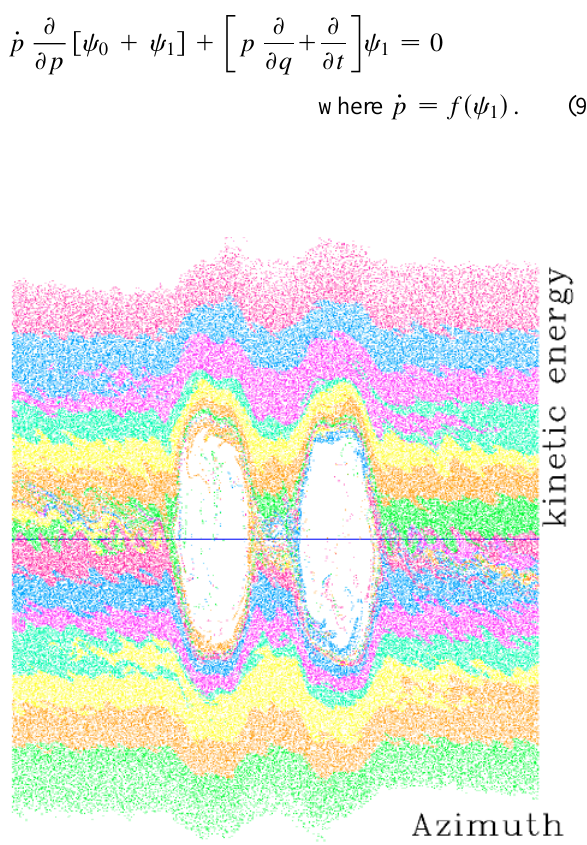
FIG. 25. (Color) Scatter plot at 2 13.54 ms, 10 13